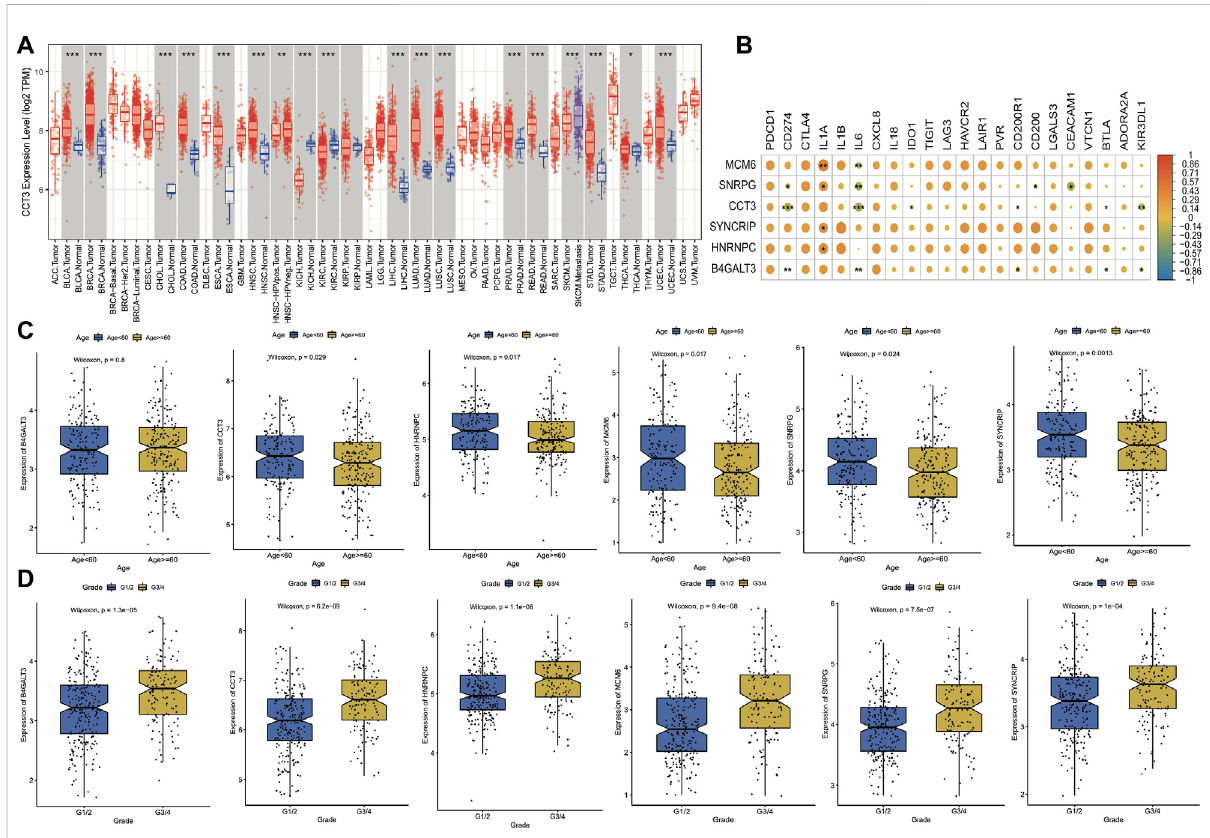
FIGURE 12 Expression and clinical signi fi cance of model genes. (A) Box line plot of model gene expressionin pan-cancer, if Normal samples are present in the TCGA cohort for that cancer, they are also plotted simultaneously and expressed in blue; (B) Thermographic of the correlation coef fi cient between modelgeneandimmunecheckpointexpression,thecolorofthedot representshighcorrelationand*represents signi fi cance; (C) Boxline plot of model gene expression difference in Age grouping, where blue is Age < 60 and yellow is Age > =60; (D) Box line plot of expression differences of model genes in Grade grouping, where blue is G1/2 and yellow is G3/4.